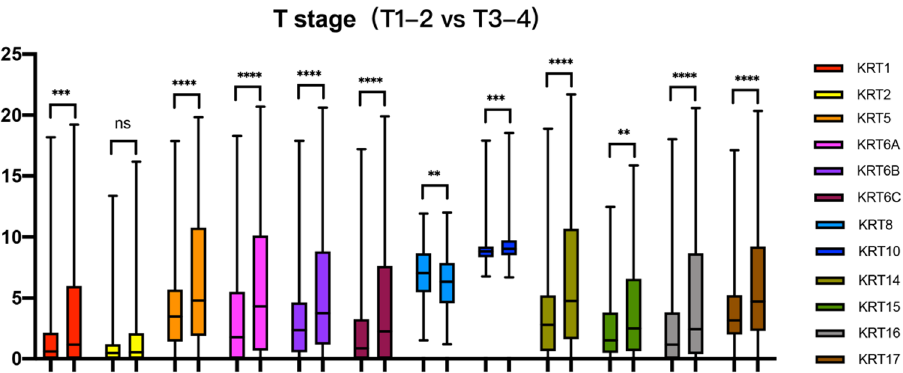
Figure 3. Relationship between transcriptional expressions of distinct KRTs family members and T stage of SKCM patients. Except KRT2 , KRT1/5/6/10/14/15/16/17 all showed significant correlations with SKCM patients (ns: no significance,* P < 0.05, ** P < 0.01, *** P <